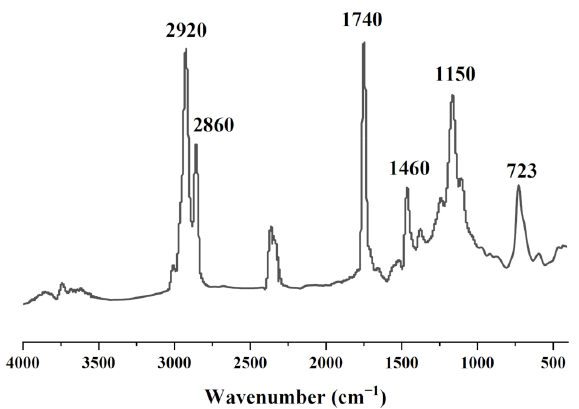
Figure 1. FTIR spectra of coix seed